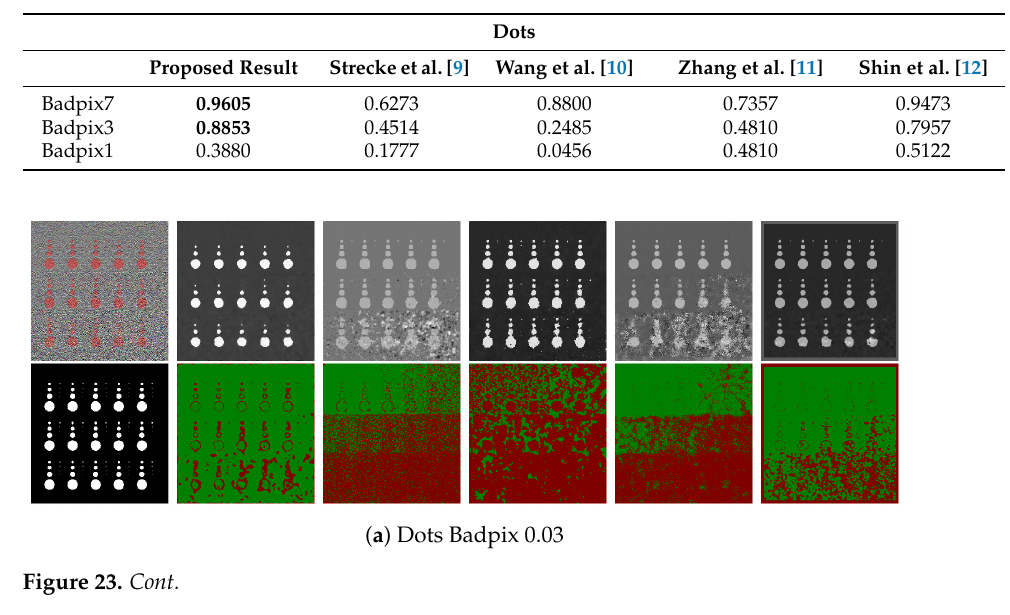
Table 4. Comparison for the ‘dot’ image with ground truth for proposed and state-of-the-art algorithms.